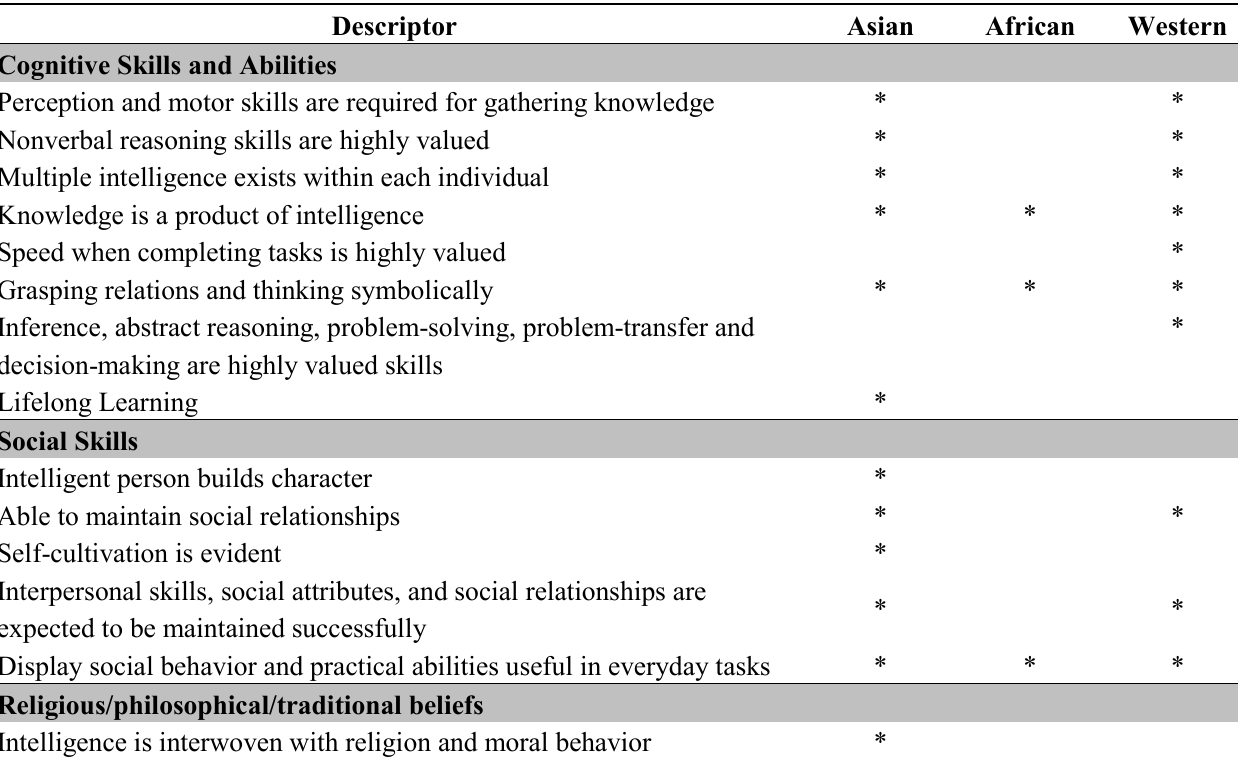
Table 1. Overview of implicit theories of intelligence in Asian, African, and Western cultures.